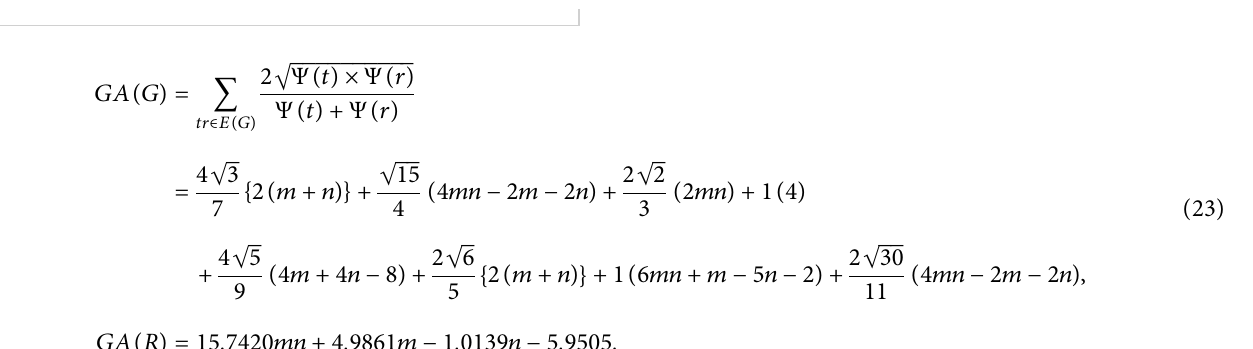
Figure 6: The graphical representation of Table